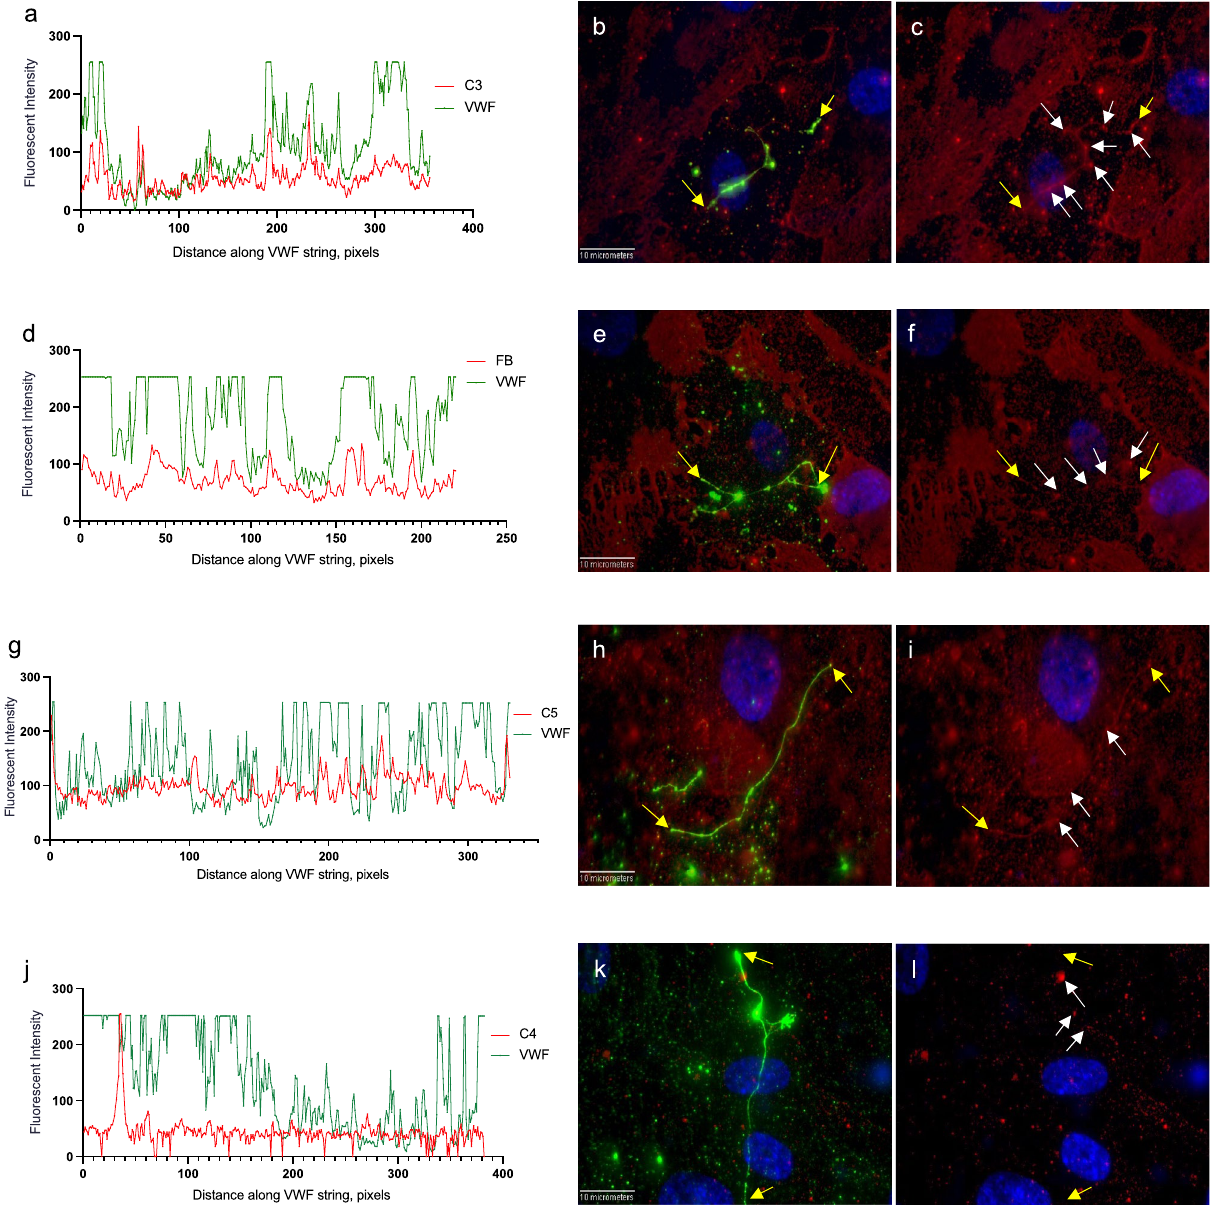
Figure 4. GMVEC-released C3, FB, C5, although not C4, bind to cell-secreted ULVWF strings. GMVECs were stimulated with 100 µM histamine for 2 min, followed by addition of rabbit anti-VWF + chicken anti-rabbit AF-488 (green) for 15 min. Cells were then p-formaldehyde-fixed and stained with goat antibodies against: C3 ( a – c ); FB ( d–f ); C5 ( g–i ); and C4 ( j–l ); and secondary donkey anti-goat AF-647 (red). Cell nuclei were detected with DAPI (blue). Graphs show the fluorescent intensities (y-axis) measured along the ULVWF string (x-axis, length in pixels, 1 pixel = 0.114 µm) from merged images of detected VWF with each complement protein. The yellow arrows in the merged images indicate the start and end points of the strings. The white arrows in the merged images of complement proteins (647 nm, red) with DAPI detection indicate high 647-intensity values (in order to assist visualization of the measured line). Images were obtained at 60X and were selected from over 100 (to inactivate cell membrane-bound C3b in association with co-factors FH and FI) 43 . CD141, also known as thrombomodulin, is present exclusively on EC surfaces and participates substantially in controlling coagulation 44 . Fluorescent microscopy was used to analyze and quantify the attachment of complement proteins to the GMVEC-secreted ULVWF strings. The polyclonal antibodies made against human proteins were shown pre- viously to identify each specific complement component and their activated forms 12 . The GMVEC-secreted ULVWF strings remained on EC surfaces because the added detection antibodies against VWF impeded string cleavage by ADAMTS-13 released from ECs 12 .